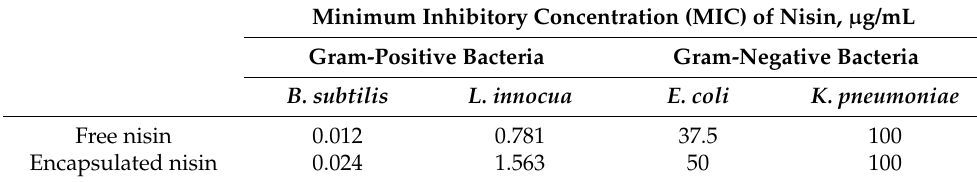
Figure 7. The viability of L. innocua ( a ) and B. subtilis ( b ) under the action of nisin-loaded ulvan (Nis-Ulv) particles, free ulvan (Ulv) or nisin solution (Nis) performed in carrot juice (columns with dots) and 0.9% NaCl solution (columns without dots). In control experiments (K), bacterial cells in carrot juice or 0.9% NaCl were incubated without additives. The data are given as log CFU/mL survival. Significant differences ( p < 0.05) between the survival of the indicator organisms in the control and the treatment groups are marked A and B in 0.9% NaCl solution and juice, respectively. The absence of a letter means insignificant differences. Table 2. Minimum inhibitory concentration of free and encapsulated